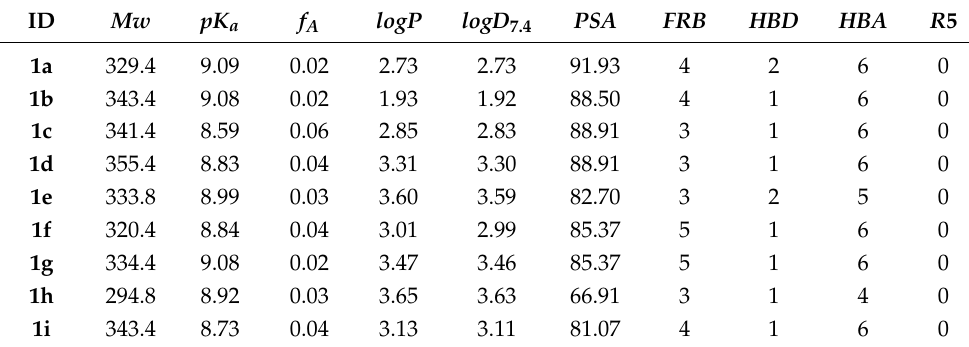
Table 3. Physicochemical properties of the designed arylsulfonyl hydrazones: Mw —molecular weight; pK a , f A —fraction of the ionized molecules; logP ; logD 7.4 —distribution coefficient at pH 7.4; PSA —polar surface area; FRB —free rotatable bonds; HBD —hydrogen bond donors; HBA —hydrogen bond acceptors; R 5 — violation of Lipinski’s Rule of